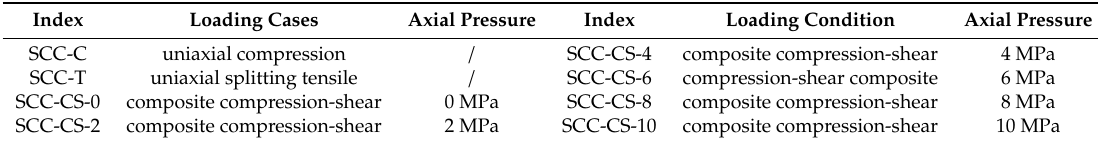
Table 3. Loading cases of self-compacting